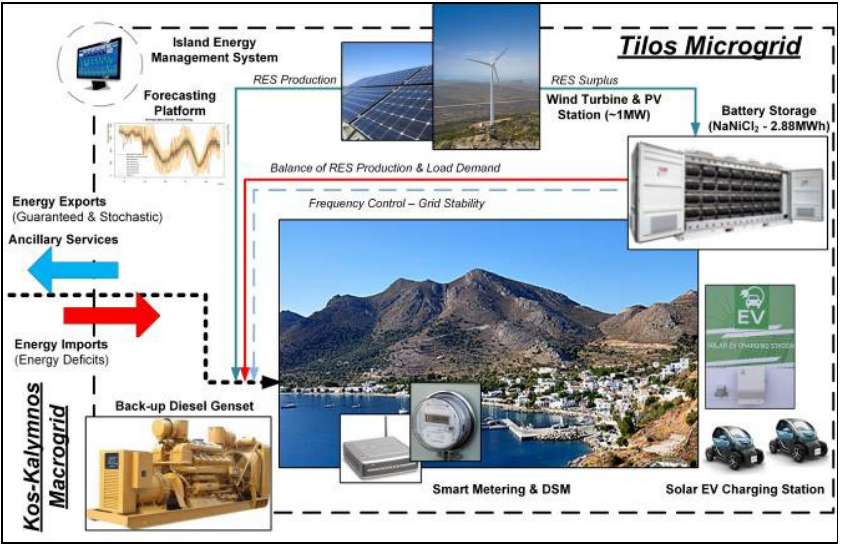
Figure 4. The RES-based energy solution for NIIs. The case of Tilos island.